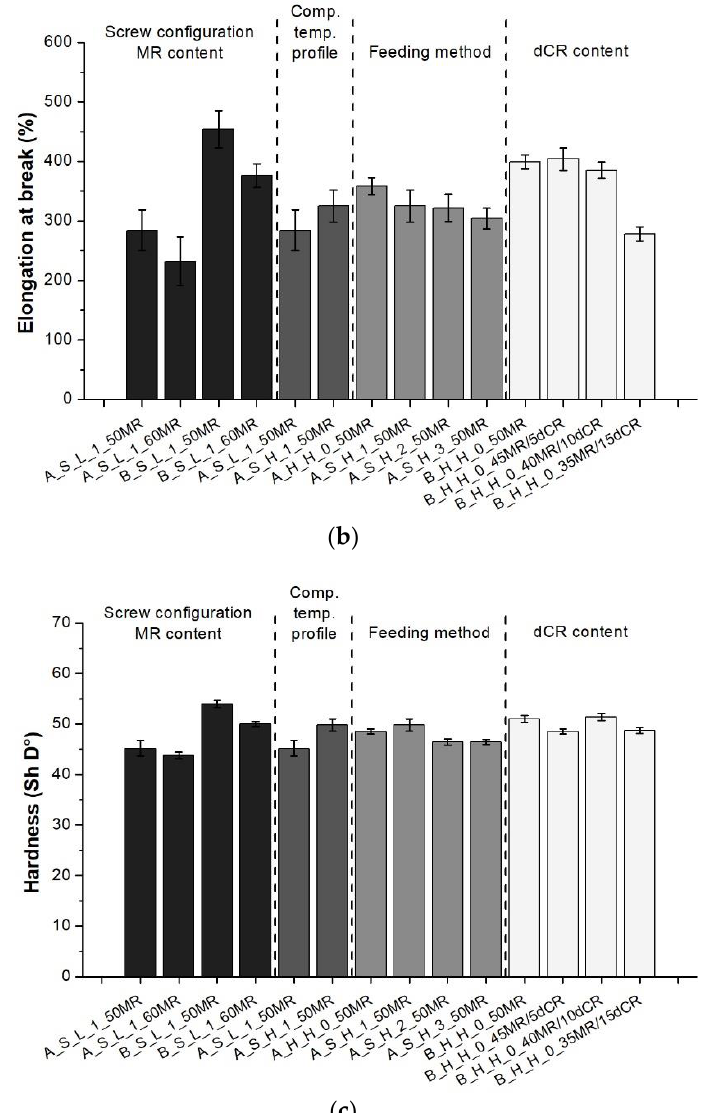
Figure 4. Ultimate tensile properties and hardness of the produced TDVs: ( a ) Tensile stress; ( b ) Elongation at break; ( c ) Hardness.